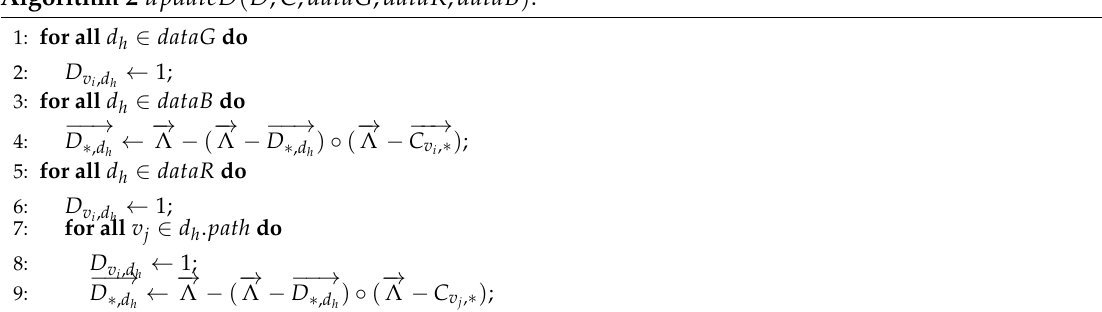
Algorithm 2 updateD ( D , C , dataG , dataR , dataB )